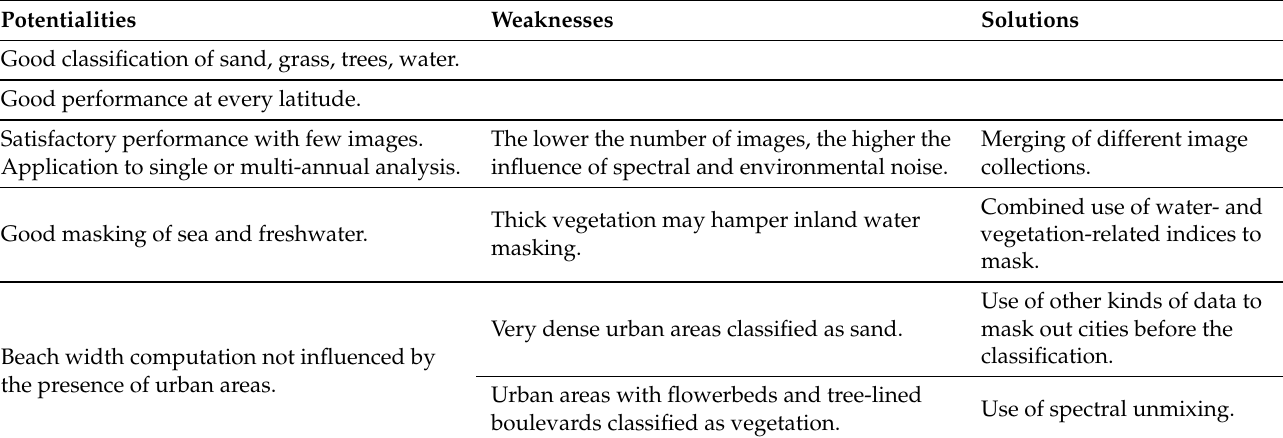
Merging of different image Combined use of water- and vegetation-related indices to mask. Use of other kinds of data to mask out cities before the classification. Use of spectral unmixing.